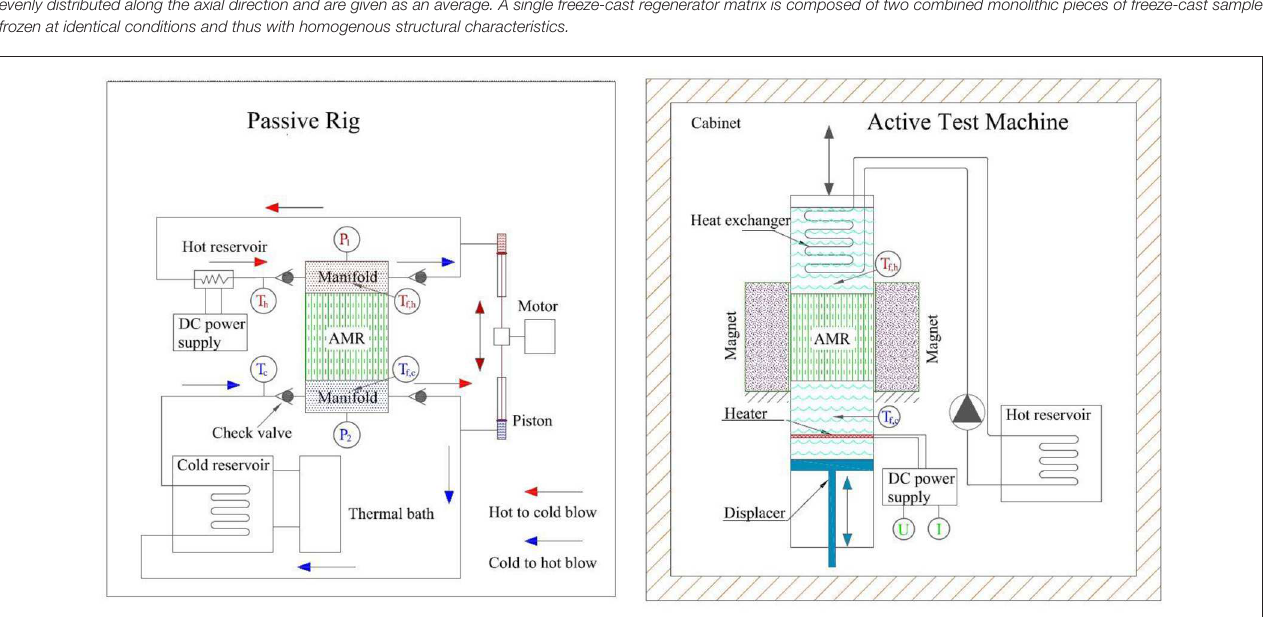
FIGURE 2 | Schematic diagram of passive rig and AMR test machine. The passive rig consists of the regenerator, manifolds, cold and hot reservoirs, piston and motor assembly, and check valves. The manifolds are situated at the ends of the regenerator, which incorporates the type E thermocouples (Omega) and pressure transducers (Gems). The thermocouples for measuring T f , h ( t ) or T f , c ( t ) are positioned at the center of the cross section between the regenerator and manifold T f , h ( t ) T f , c ( t ) T f , c ( t ) . The outflow from the manifold goes through the outlet check valve, piston, cold reservoir or heater, inlet check valve, and then back to the inlet of the manifold. The test machine, which is situated in a temperature-controlled cabinet, consists of a stationary Halbach array permanent magnet, a movable regenerator, a piston for displacing fluid, and hot and cold reservoirs. The temperature of the hot reservoir is regulated by a heat exchanger interacting with the ambient in a cabinet. The heat load in the cold reservoir is simulated by a resistance heater. The whole experiment procedure goes through: (1) passive test with different operating parameters; (2) passive test with different manifolds; (3) repetition of passive experiments; (4) active test; and (5) repetition of passive